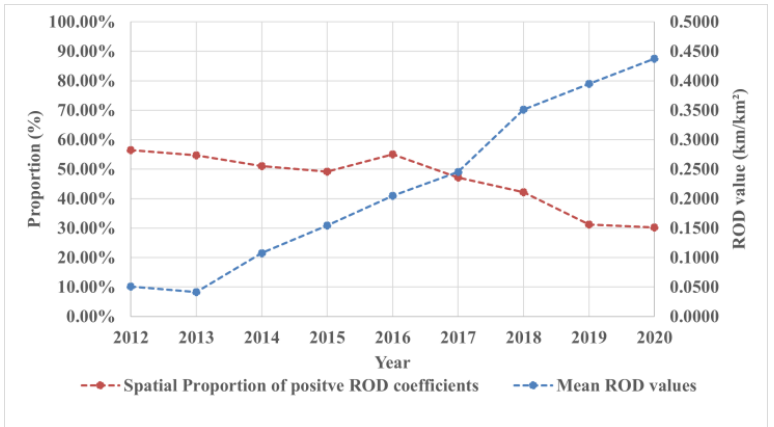
Figure 13. Temporal trends of mean ROD values and spatial proportion of positive ROD coeffi- cients.